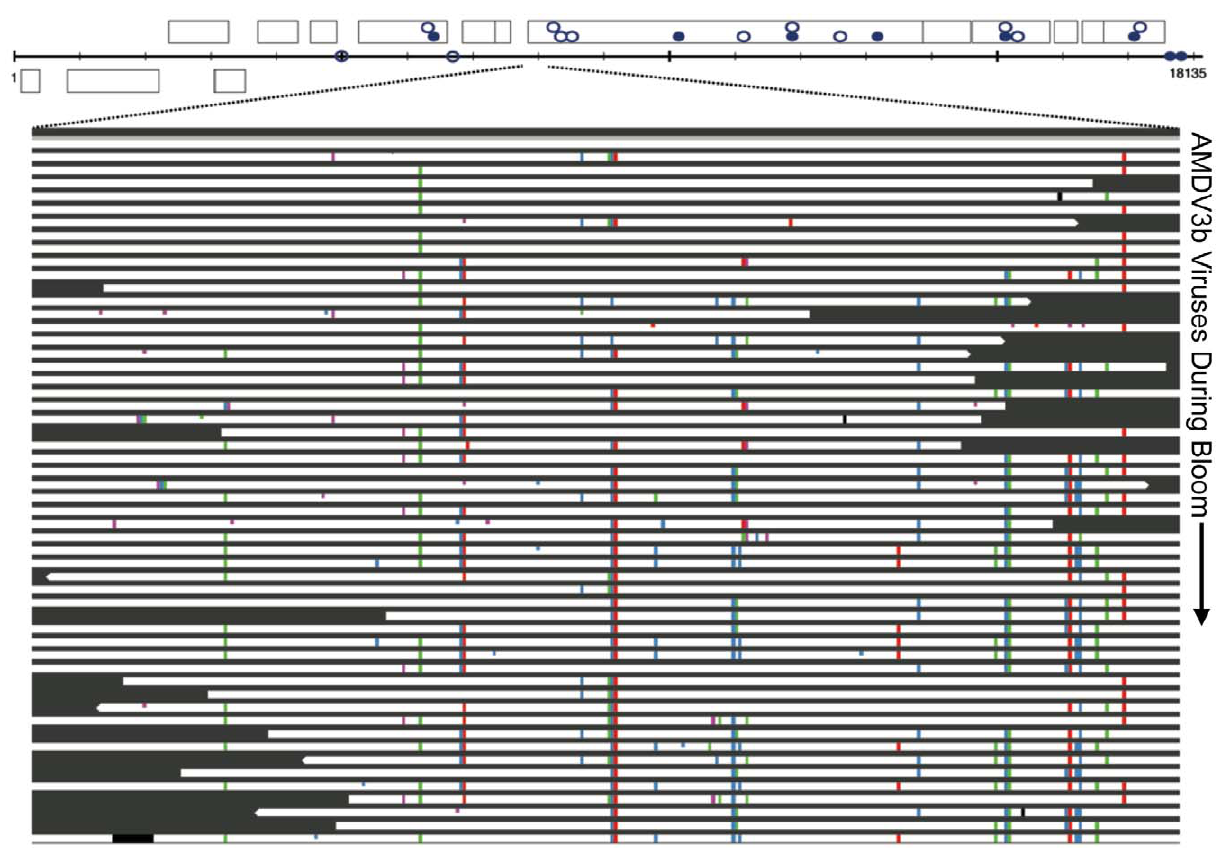
Figure 9. Natural viral bloom is polyclonal. Sequence variation within a gene of the blooming AMDV3b viral population (345 bp field of view). The top bar of the figure represents an 18 kb contig sequence of AMDV3b, with predicted genes shown as boxes. Below the contig, is a close-up view of sequence variation within a single gene. White bars represent aligned sequencing reads, while colored bars indicate SNPs relative to the composite sequence. The black region is a large deleted sequence block in one individual viral genome. Distinct viral sub-populations are captured during the bloom, each sharing common SNPs. Also shown in the figure are regions of the AMDV3b contig that match G-plasma spacers: closed circles in the contig represent perfect matches and open circles represent imperfect matches. When the match between G-plasma spacer and AMDV3b protospacer occurs within a predicted gene, the circle is placed inside the corresponding gene box; matches to intergenic regions are shown below on the contig